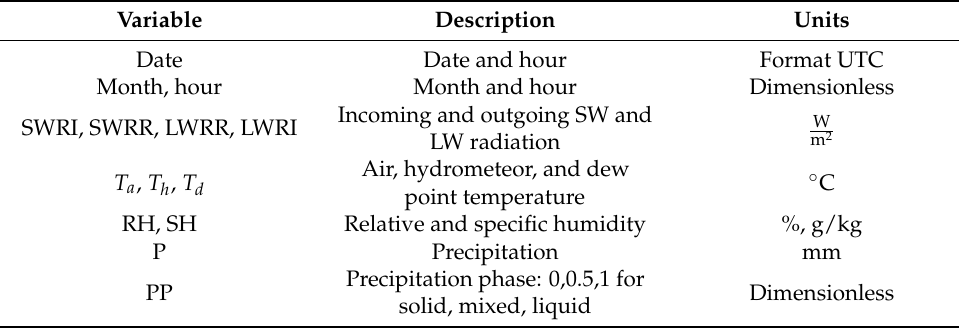
Table 2. List of variables used in this study.